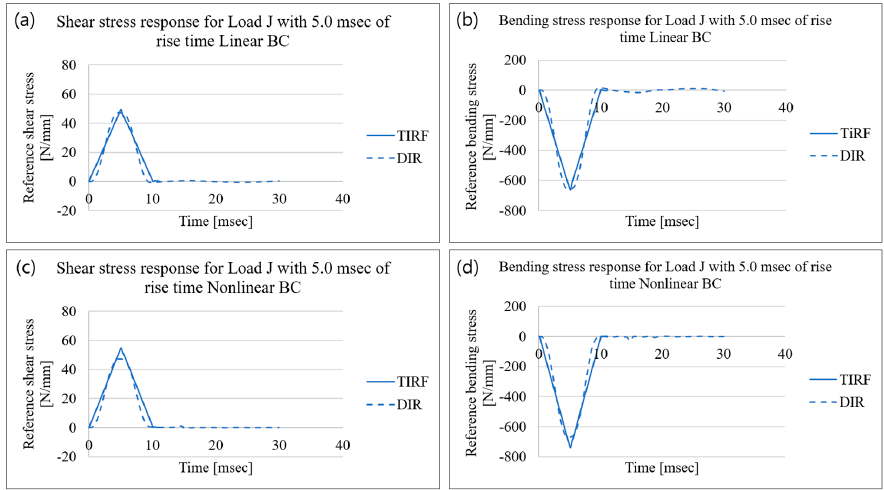
Figure 13. Reference shear and bending responses for Load J (3 × 1 load case) using TIRF and DIR for impact pressure of 5.0 ms of rise time: ( a ) Reference shear responses with linear boundary conditions, ( b ) Reference bending responses with linear boundary conditions, ( c ) Reference shear responses with nonlinear boundary conditions, and ( d ) Reference bending responses with nonlinear boundary